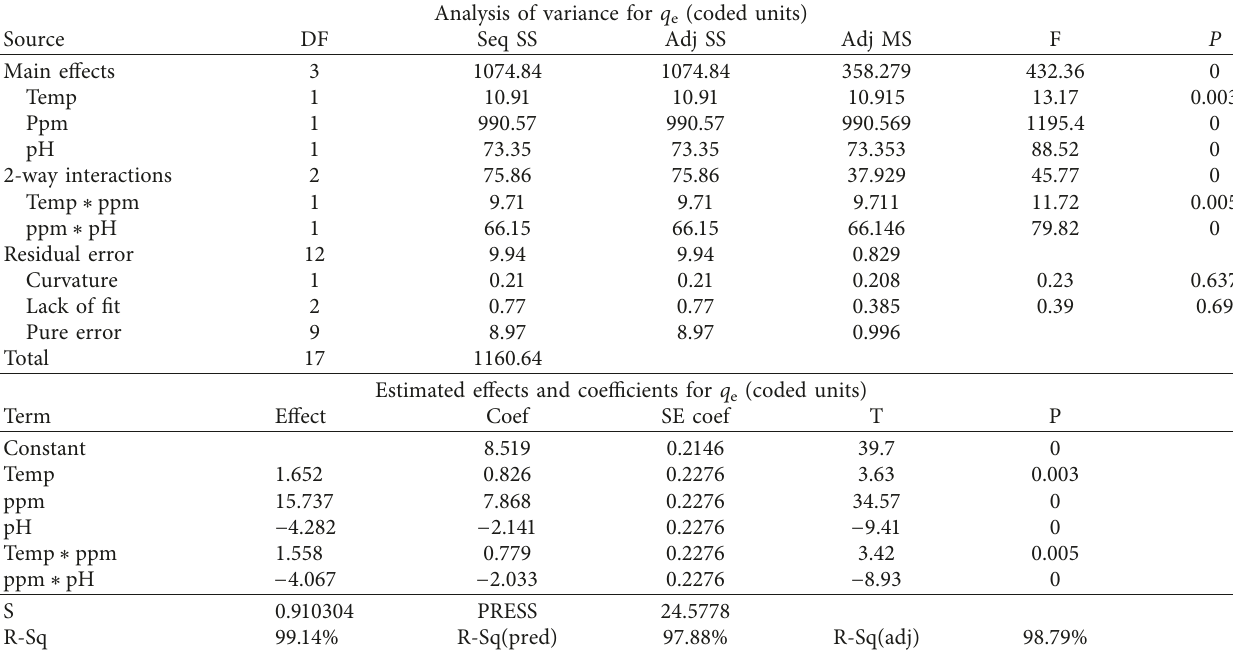
Table 4: Results of the regression analysis. Analysis of variance for q e (coded units)